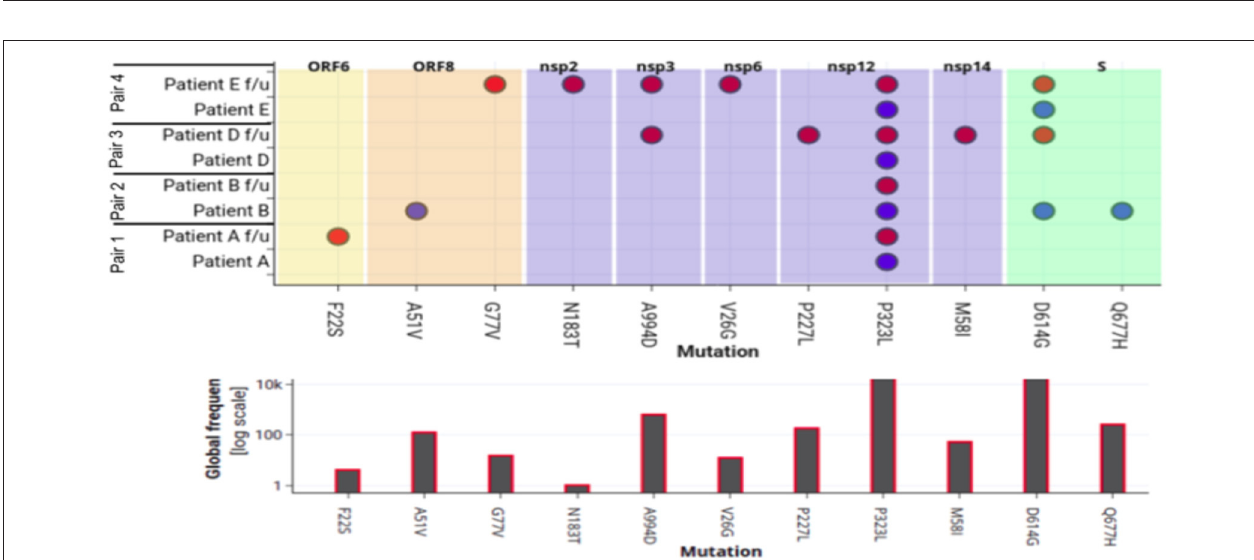
FIGURE 3 | Heatmap with 42 overall mutations (unique set of 25 mutations). Purple, mustard yellow, and sky blue colors show the presence of mutation in samples while gray color shows the absence of mutation in samples.